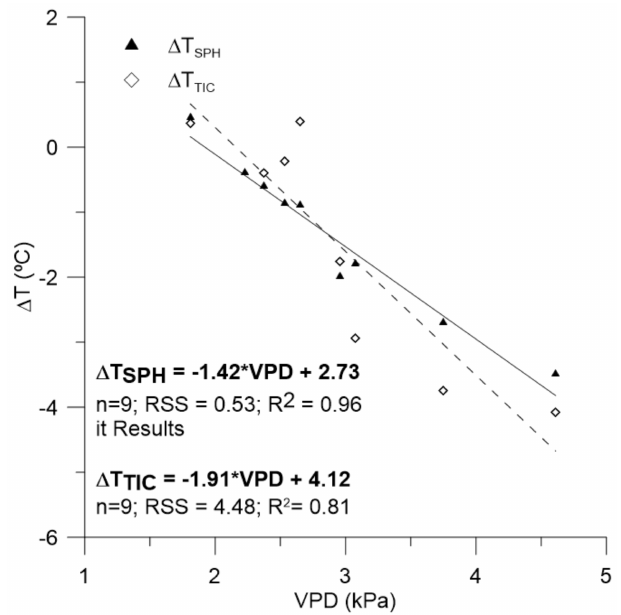
Figure 6. Non-water stressed baselines between the vapour pressure deficit (VPD) and the difference between the canopy and air temperature for both cameras Flir One thermal camera connected to smartphone ( ∆ T SPH ) and a Flir SC660 camera ( ∆ T TIC